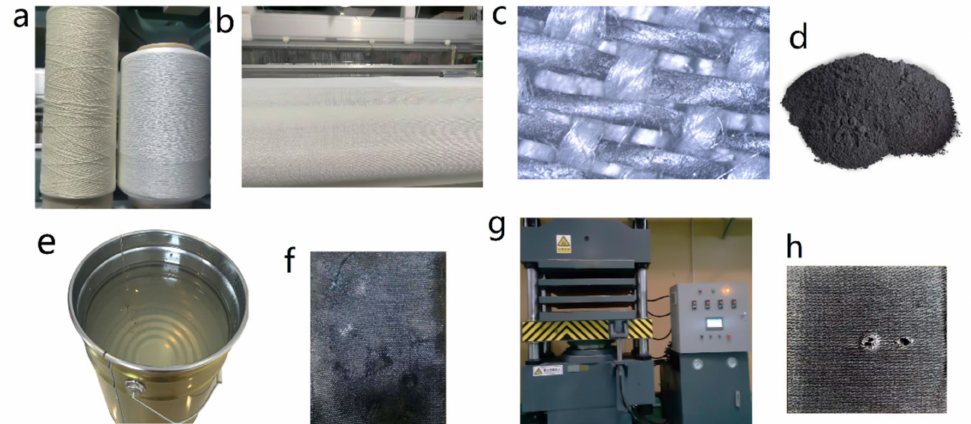
Figure 1. Fabric sample preparation process, ( a ) Nomex and PTFE fibers, ( b ) weaving machine, ( c ) microscope images of hybrid PTFE/Nomex fabric, ( d ) graphite filler, ( e ) epoxy resin, ( f ) pre- impregnated fabric, ( g ) curing press and ( h ) fabric